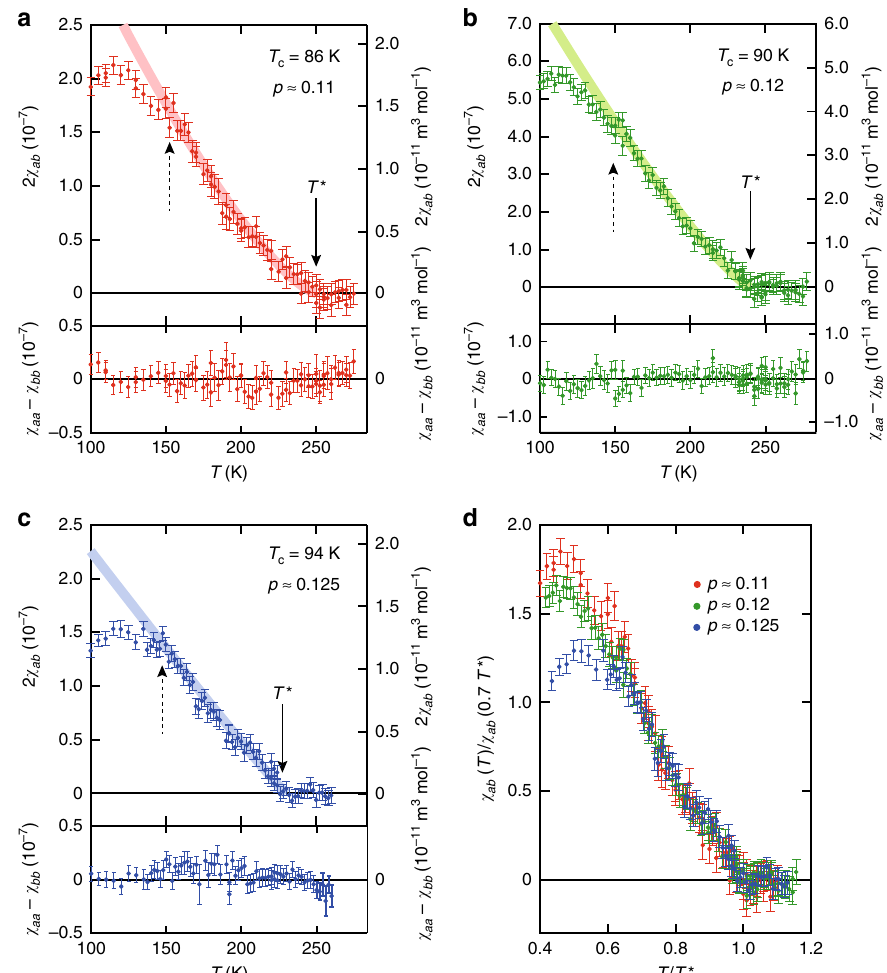
Fig. 4 Anisotropy of magnetic susceptibility. a Temperature dependence of 2 χ ab (upper panel) and χ aa − χ bb (lower panel) for p ≈ 0.11. b , c Same plots for p ≈ 0.12 and 0.125, respectively. Solid arrows indicate the onset temperatures of χ ab , which well coincides with T * , as shown in Fig. 1. Dashed arrows indicate the temperatures at which χ ab deviates from the extrapolation from high temperature shown by the bold lines. These temperatures are close to T CDW , as shown in Fig. 1. d χ ab , normalised by the values at T / T * = 0.7 for different doping levels plotted as a function of T / T * . The data collapse onto a universal curve, except for the low-temperature regime where a suppression of the χ ab is observed, indicating a scaling behaviour. Error bar represents s.d. of the sinusoidal fi t to the τ 2 ϕ ( ϕ )